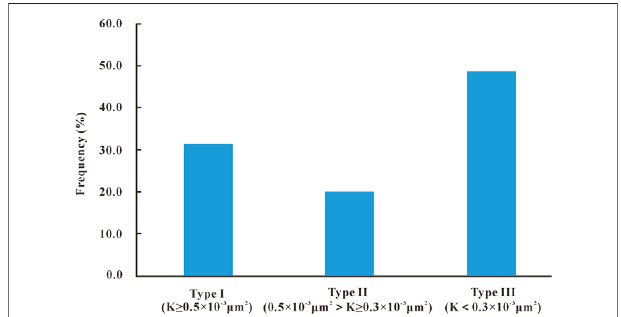
FIGURE 5 | Division of reservoir types in the Chang 3 Member.